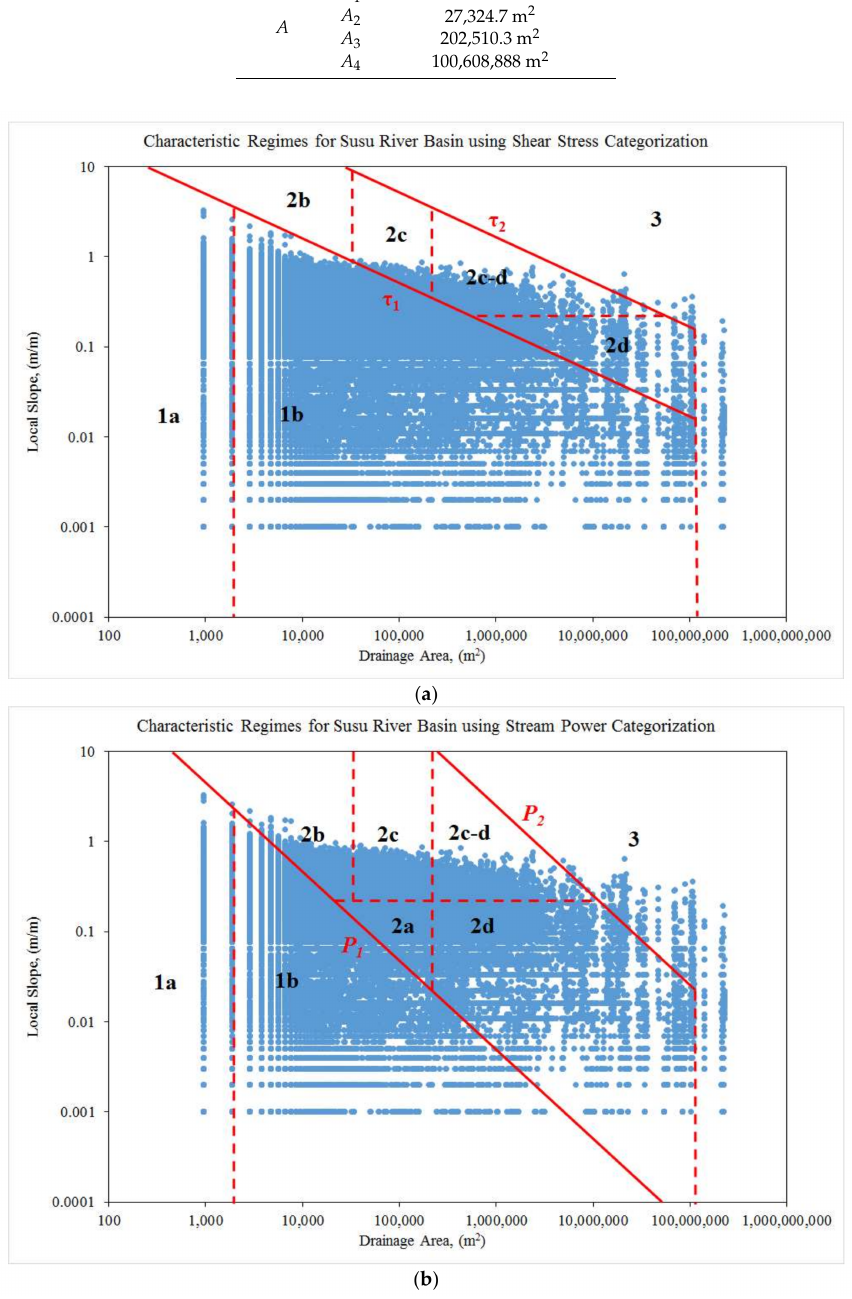
Figure 6. Characteristic regimes for the Susu River Basin using classification of ( a ) shear stress and ( b ) stream